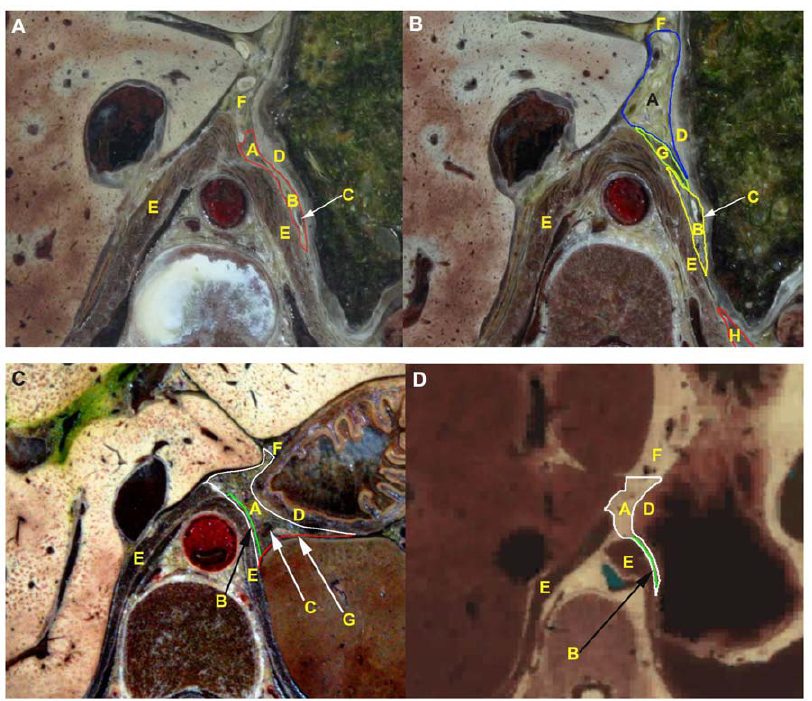
Figure 3. Spatial relationship between the GBA and LSFS on cross-sections from the inferior. (A) The GBA and LSFS overlap on upper sections of CVH2. (B) The GBA and the LSFS are separated by the lower segment of the left layer of the gastrophrenic ligament on lower sections of CVH2. (C, D) The LSFS is superimposed on the GBA on cross-sections of the CVH1 and VHMA. The thin adipose layer located between the white and green lines represents the LSFS. A: GBA; B: LSFS; C: posterior gastric vein; D: gastric wall; E: diaphragm; F: lesser omentum; G: lower segment of the left layer of the gastrophrenic ligament; H: left retroperitoneal space.